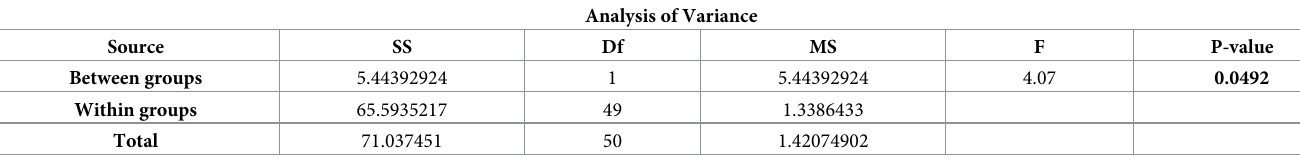
Table 8. Comparison of mean total protein with BMI categories among cases (One way ANOVA).